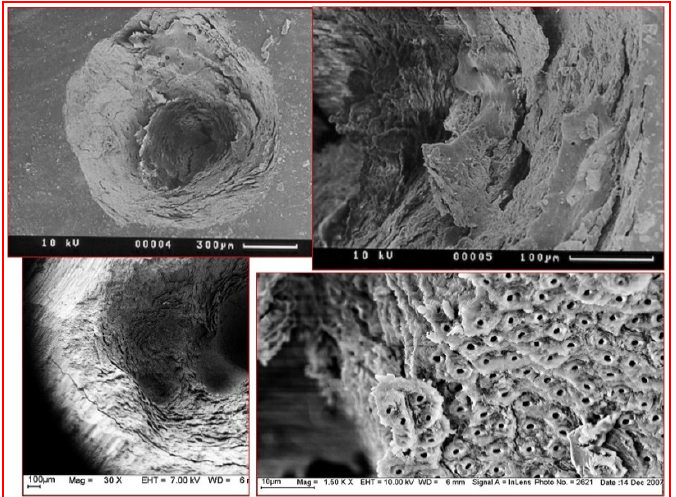
Figure 8. Scanning Electron Microscope (SEM) micrographs of laser-mediated enamel and dentine ablation. Top left and right: the resultant enamel surface is rugged, fragmented and capable of accepting a resin-based composite restoration once any unstable fragments have been removed. Bottom left and right: dentine is rendered smear layer-free, with an intact and stable cut surface.